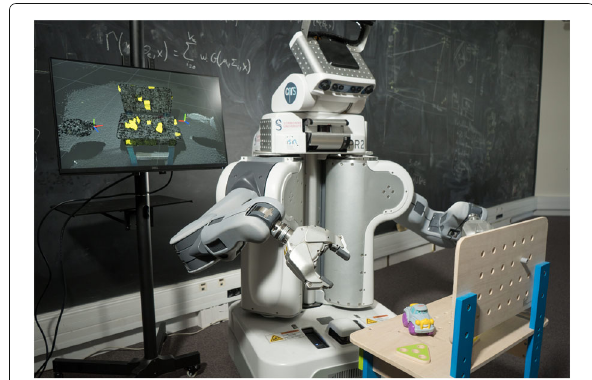
Fig. 2 A PR2 robot engaged in an interactive perception experiment to learn a segmentation of its visual scene [93, 94]. The interaction of the robot with its surrounding environment provides data to learn to discriminate objects that can be moved by the robot from the background (Copyright: Sorbonne